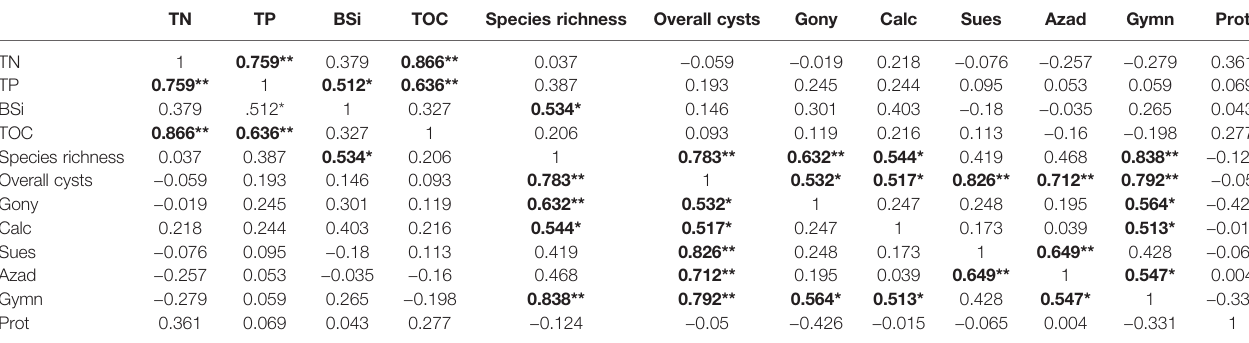
TABLE 2 | Pearson correlation coef fi cients between dino fl agellate cysts and biogenic elements. TN TP BSi TOC Species richness Overall